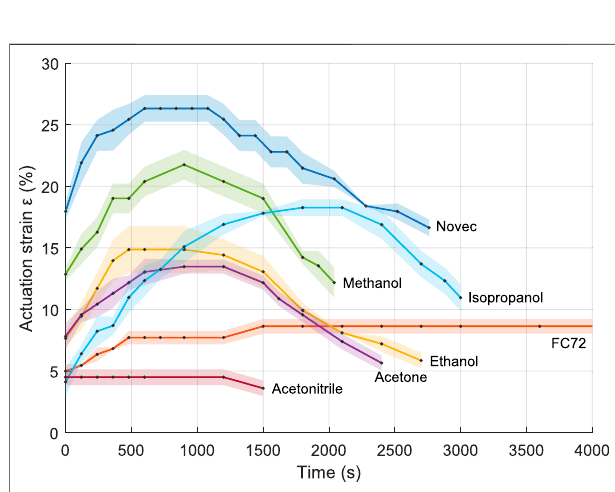
FIGURE 4 | Actuation strain as a function of the time for the different fl uids, response to a 5 ° temperature step above boiling. The shaded areas represent the standard deviation; the data points are in black.